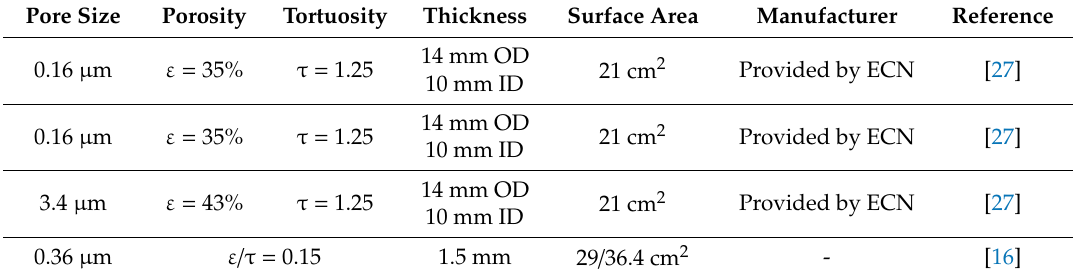
Table 3. Ceramic support